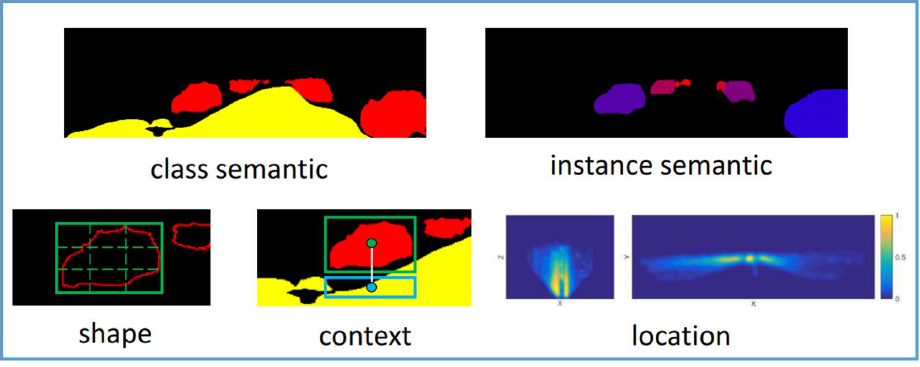
Figure 4. Information used in